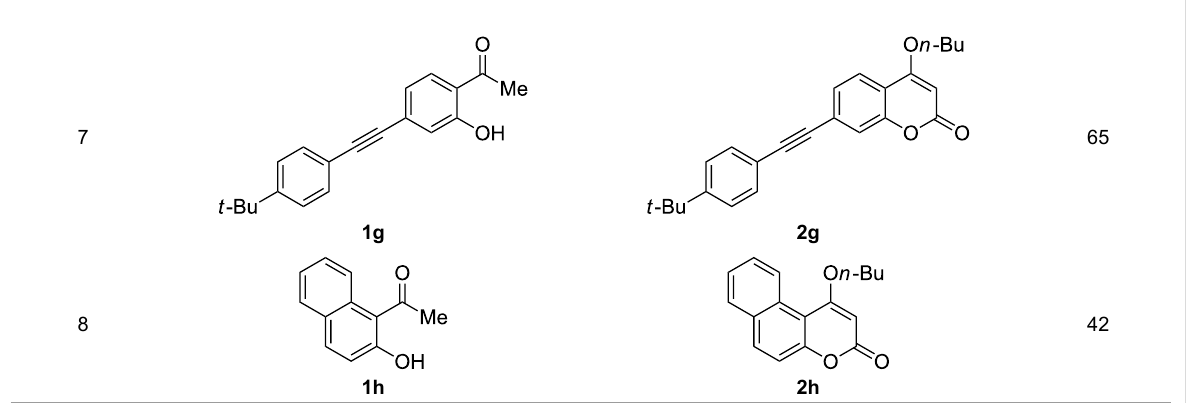
(Table 2, entries 6 and 7). 2-Hydroxy-1-acetylnaphthalene ( 1h ) participates in the carboxylative cyclization reaction to furnish the tricyclic product 2h in moderate yield (Table 2, entry